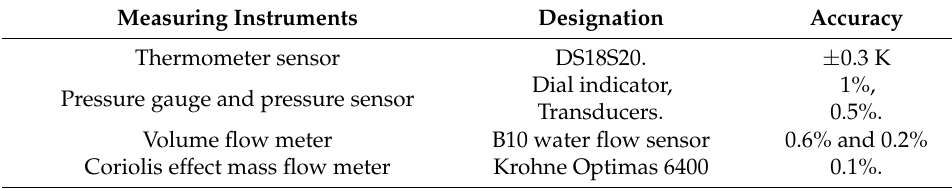
Figure 2. The measurement setup. Table 3. The measuring instruments’ characteristics.